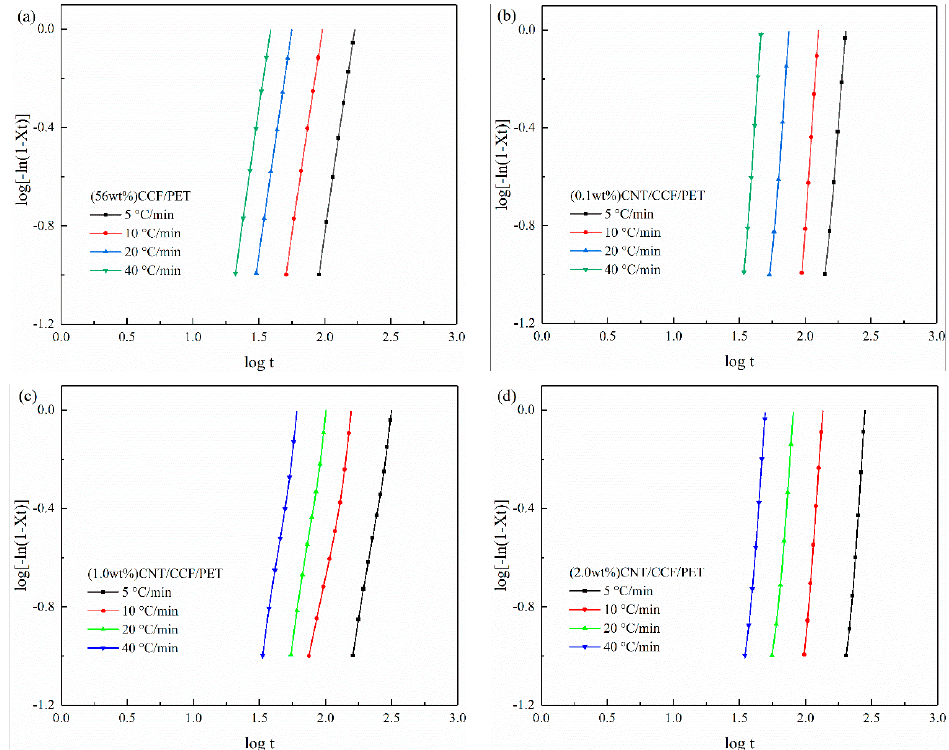
Figure 11. Avrami plots of log[ − ln(1 − Xt)] versus log t at different cooling rates: ( a ) (56 wt%) CCF/PET, ( b ) (0.1 wt%) CNT/CCF/PET, ( c ) (1.0 wt%) CNT/CCF/PET, ( d ) (2.0 wt%)